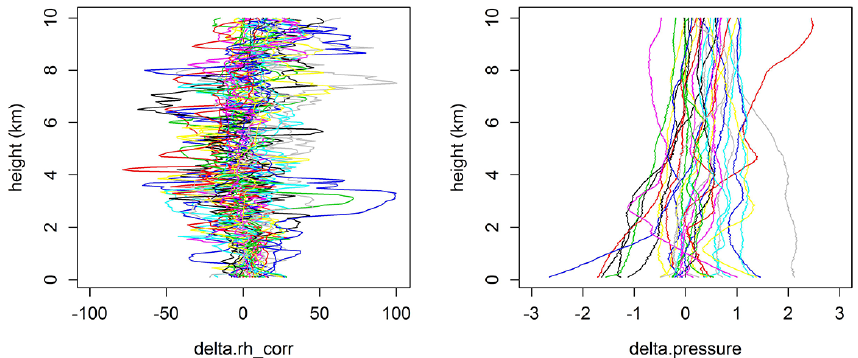
Figure 4. Collocation mismatch profiles (1 µ ) given by differences BV–NWS. Left: relative humidity (1 rh ) ; right: pressure (1p)